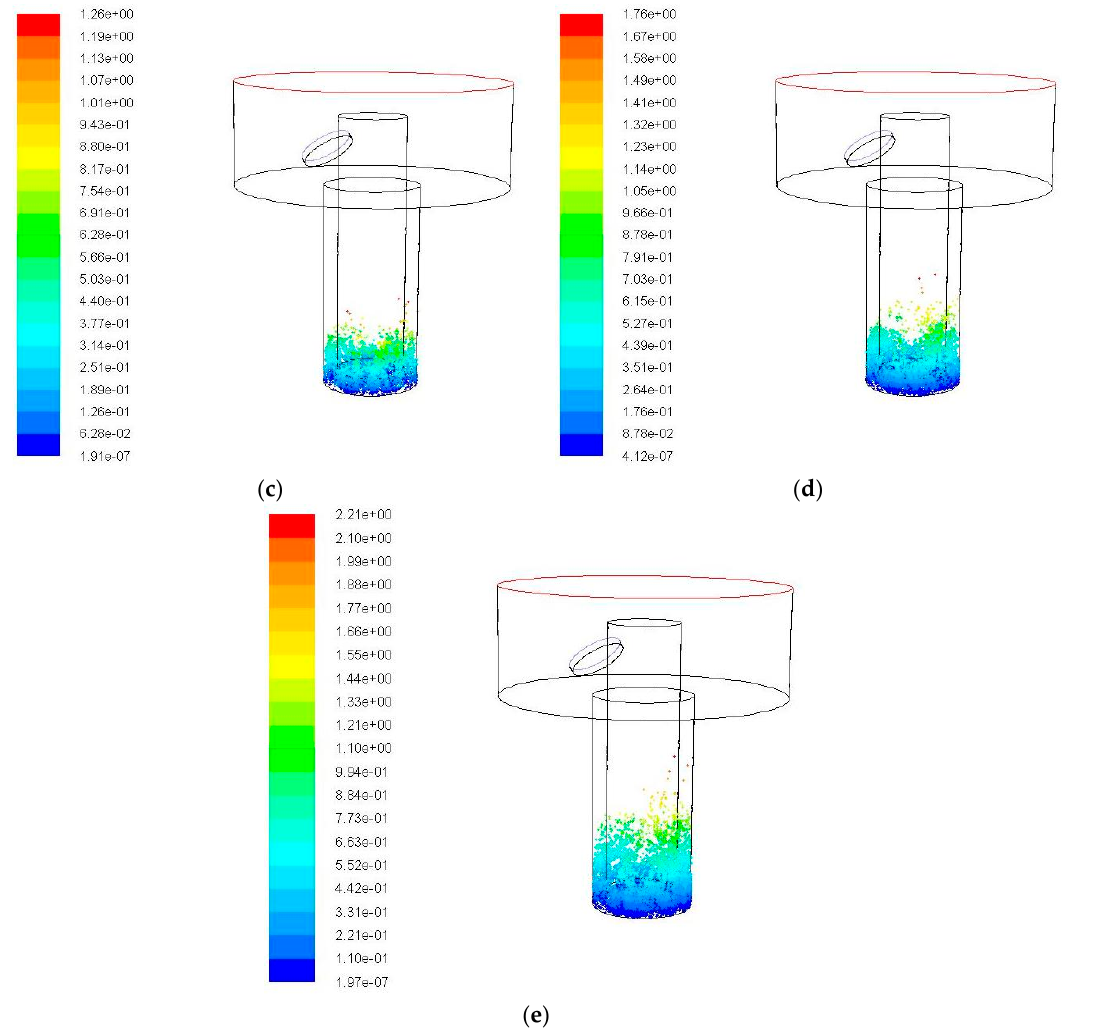
Figure 7. The debris movement with time when ultrasonic frequency is 20 kHz, amplitude is 10 μ m. ( a ) Initial debris distribution; ( b ) Debris distribution at 0.01 s; ( c ) Debris distribution at 0.02 s; ( d ) Debris distribution at 0.03 s; and, ( e ) Debris distribution at 0.04 s.